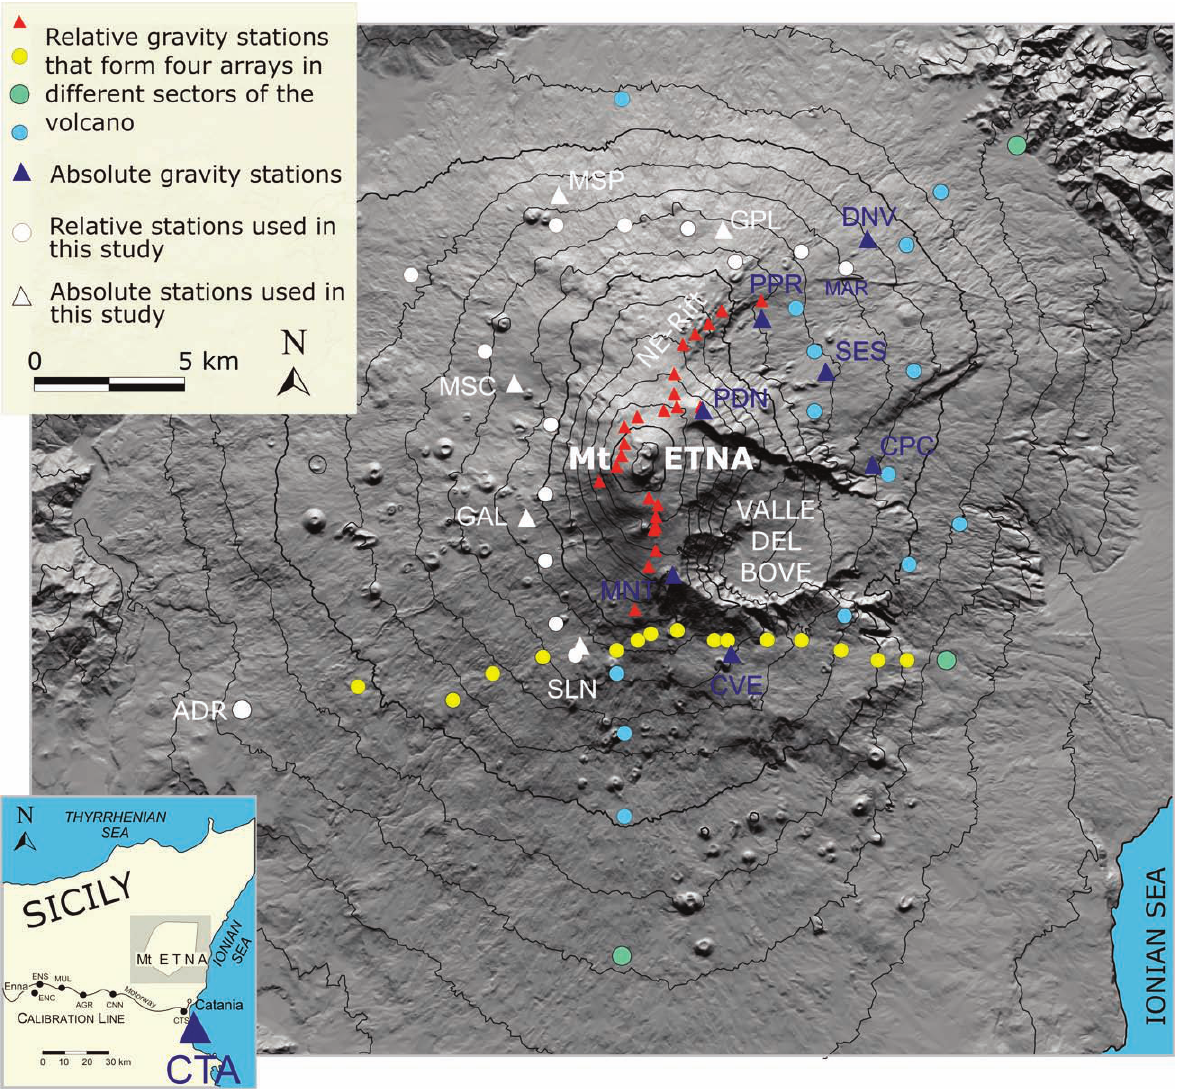
Figure 1. Sketch map of Mt Etna showing the current gravity network for absolute and relative measurements. White triangles and circles indicate, respectively, the absolute and relative stations in which the measurements reported in this study were made in 2005 and 2010. At the bottom left, the calibration line for the relative gravimeters and the CTA absolute station are also